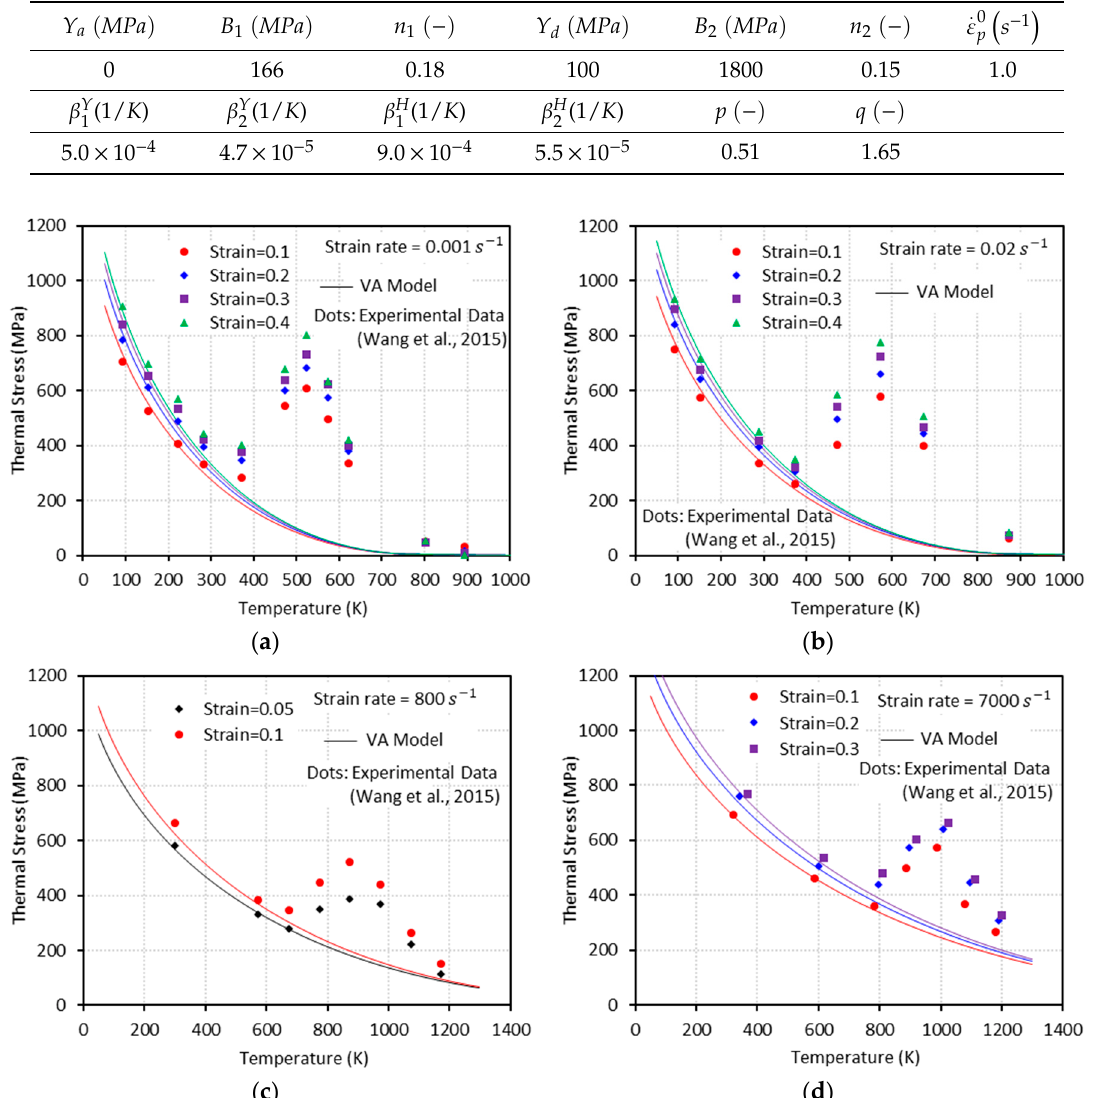
Figure 5. The thermal flow stress versus temperature curves from the experiments [1] and the VA model (Equation (15)) with ( a ) 0.001 s − 1 , ( b ) 0.02 s − 1 , ( c ) 800 s − 1 , and ( d ) 7000 s − 1